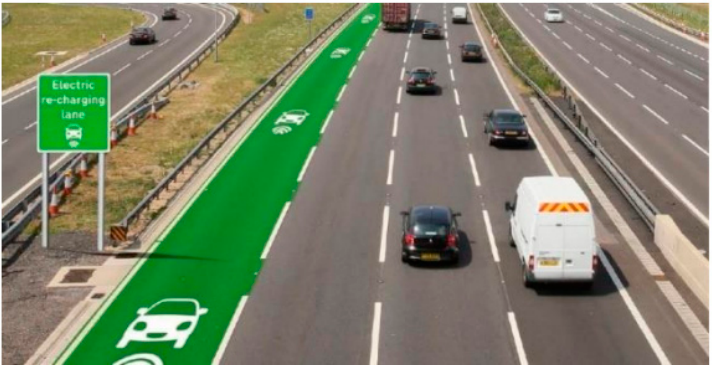
Figure 2. Highway with a